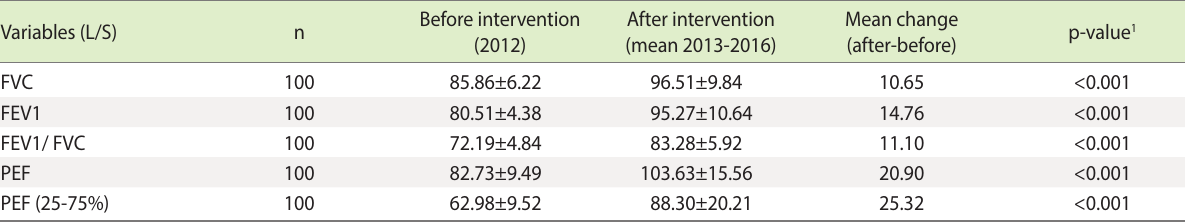
Table 3. Changes of spirometric parameters after the intervention Variables